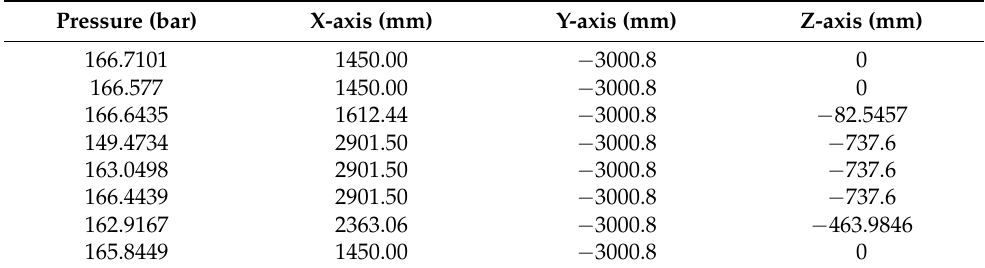
Table 1. Input data: sensor pressure (x 1 ) and the tool’s three axis positions (x 2 , x 3 and x 4 ). Pressure (bar) X-axis (mm) Y-axis (mm) Z-axis (mm) 166.7101 1450.00 −